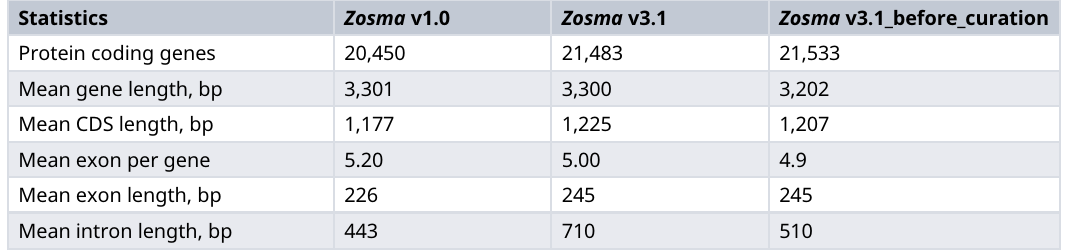
Table 5. Genome annotation statistics.